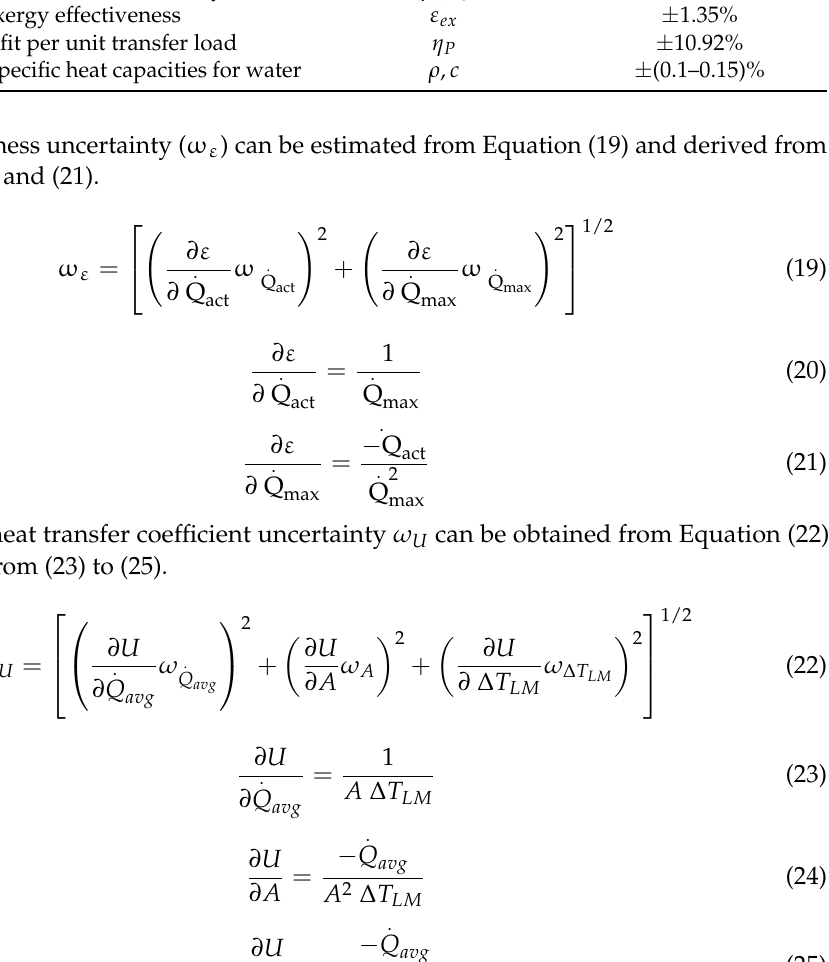
Table 2. Cont. Parameter Symbol Uncertainty Augmentation entropy generation rate N s , aug ± 11.20% . Exergy destruction rate Ex des ± 10.45% Witte-Shamsundar efficiency η W − S ± 0.78% Exergy effectiveness ε ex ± 1.35% Net profit per unit transfer load η P ± 10.92% Density, and Specific heat capacities for water ρ , c ±